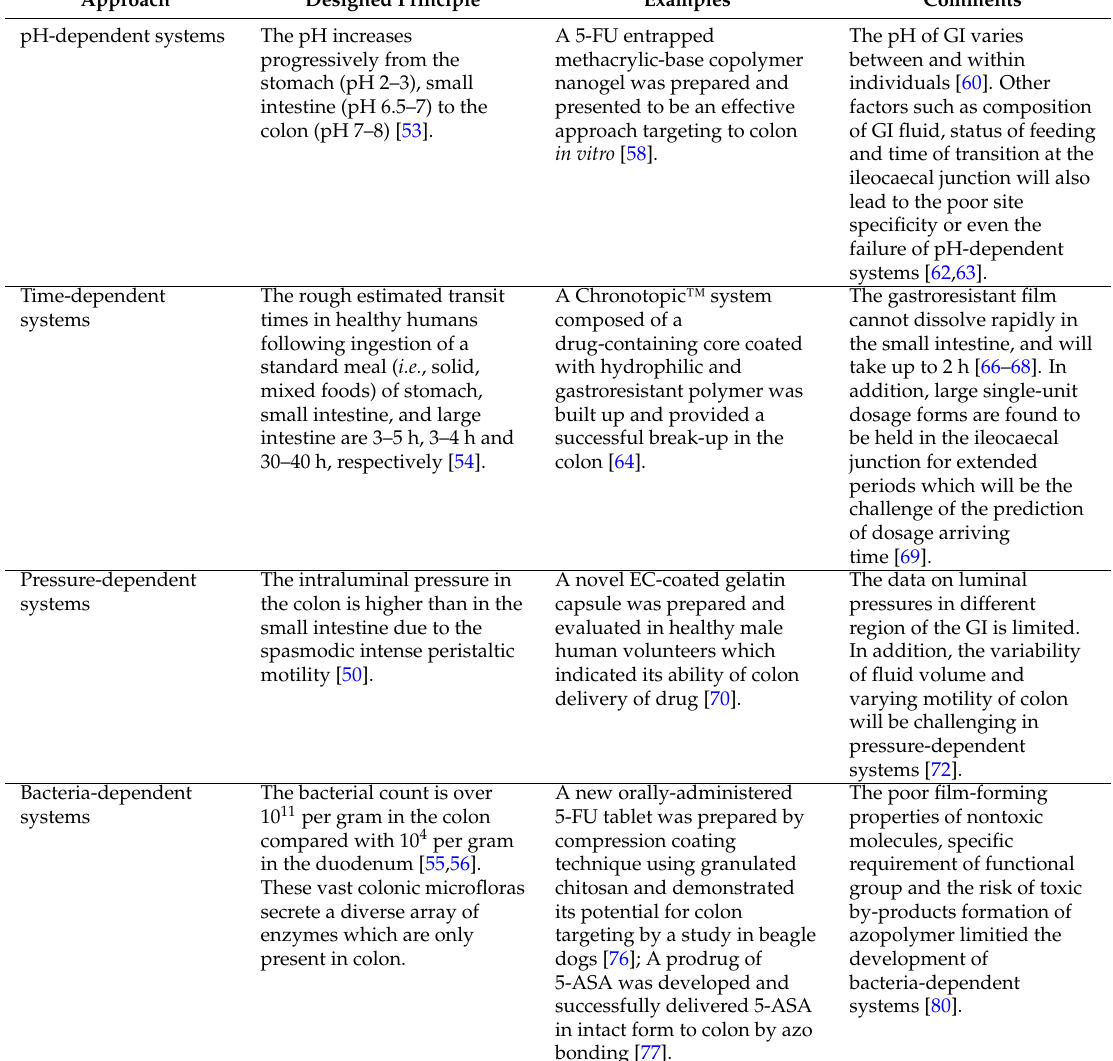
Table 3. Different Colon-specific Drug Delivery System Approaches for Colorectal